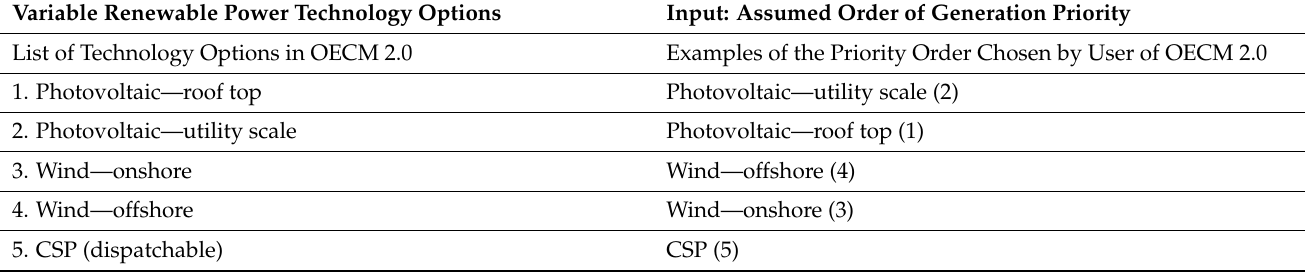
Table 10. Technology options—variable renewable energy.